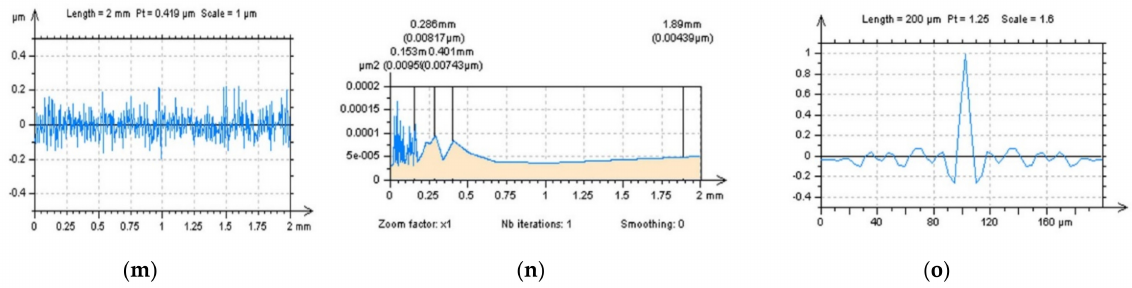
Figure 14. Profiles (left column), their PSDs (middle) and ACFs (right column) of HFNS received by application of Gaussian ( a – c ), robust Gaussian ( d – f ), median ( g – i ), spline ( j – l ) and FFTF ( m – o ) filter, cut-off = 0.015